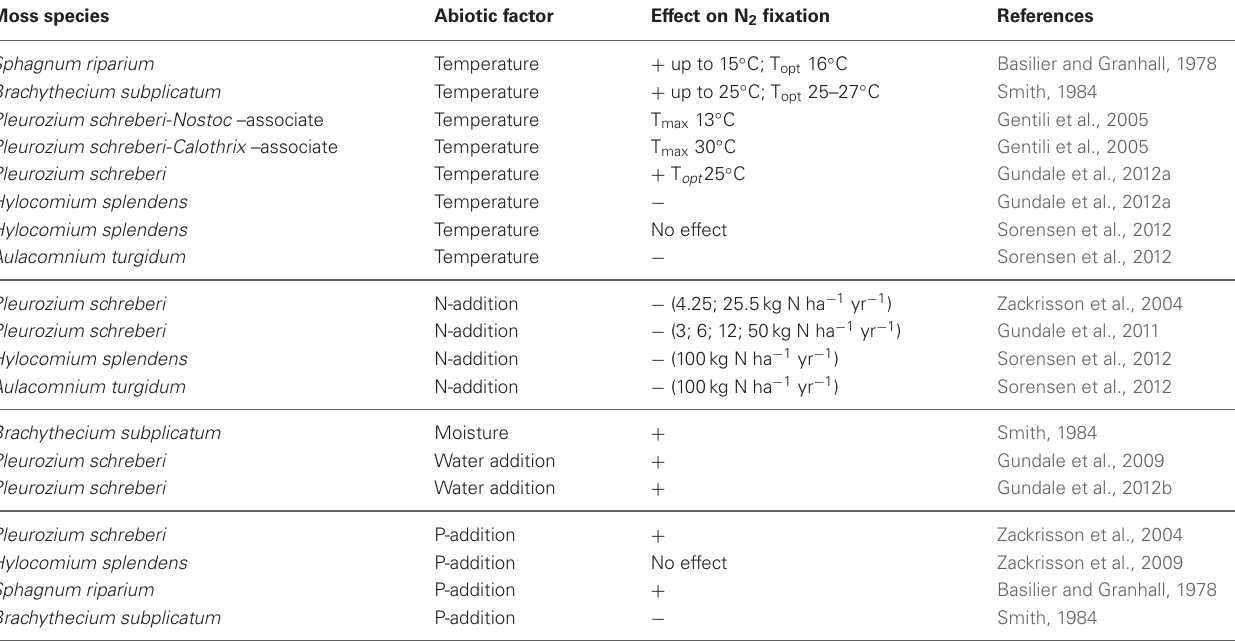
Table 1 | Effects of selected abiotic factors on N 2 fixation in different moss species from boreal and arctic environments. Moss species